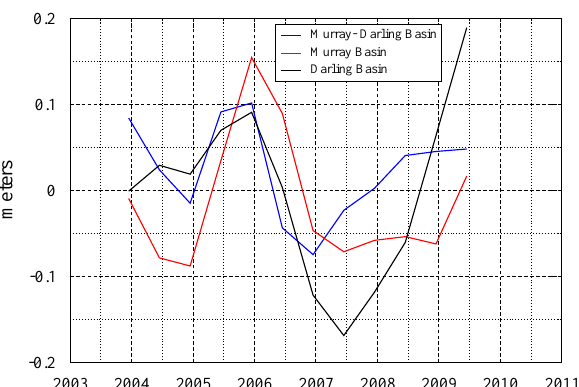
Fig. 9. (a) Temporal components of PCA 3rd orthogonal mode of regional solutions and 2nd mode of GRGS, ICA 400km-filtered solutions and rainfall product. (b) Groundwater levels from in situ measurements over Murray–Darling Basin.